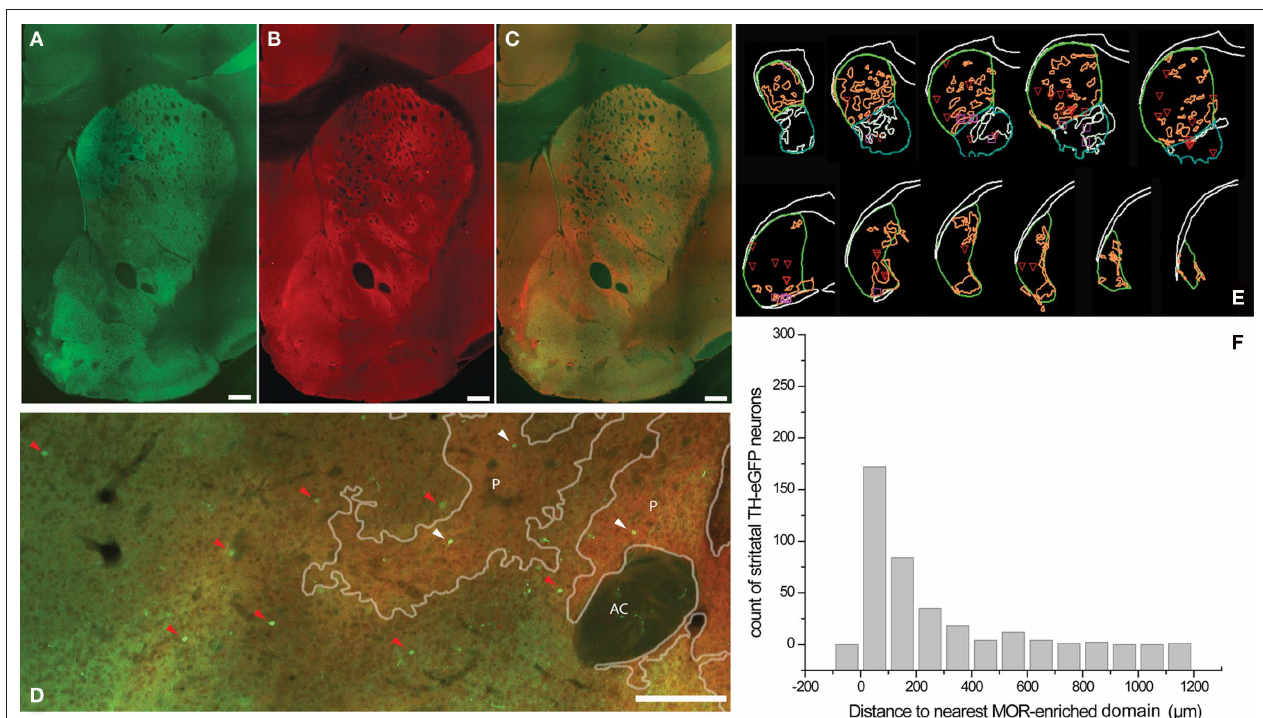
of their compartmental distribution. Red arrowheads point to the TH-eGFP somata in matrix, and white arrowheads point to the TH-eGFP somata in MOR-enriched striosomes (e) . Representative series of 60 μm sections at 300 μm intervals from one hemisphere showing MOR patches. (F) The distance to the nearest MOR patch was measured among 332 TH-eGFP neurons in the matrix. The histogram shows that half of the matrix TH-eGFP neurons are located within 100 μm of the striosome–matrix borders. Scale bars = 250 μm. AC, anterior commissure; P,